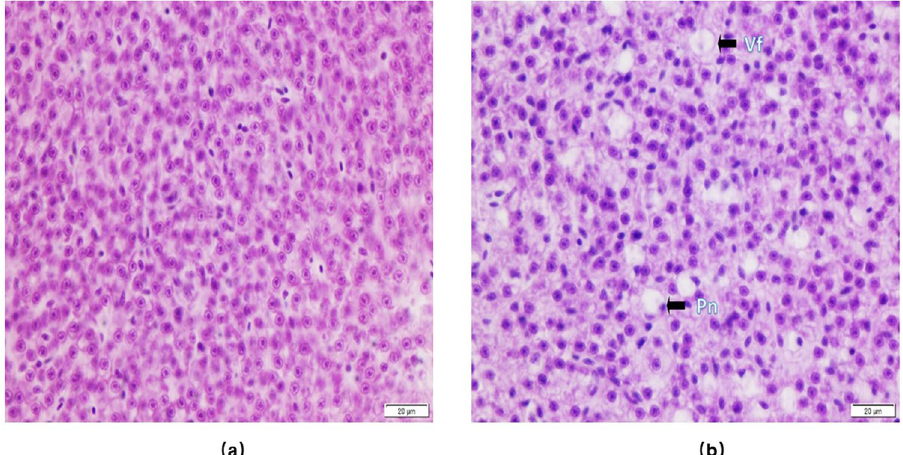
Figure 2. Histological analysis of the liver of Zebrafish in control ( a ) and upon CMC-FeS exposure ( b ). He liver of control zebrafish had normal hepatocytes, while the nanoparticle treated groups showed pyknotic nuclei (pn), and vacuole formation (vf). The scale bar represents 20 μ m.